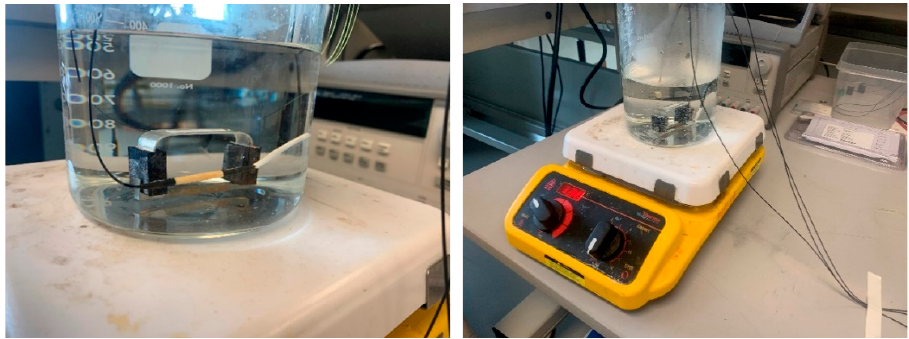
Figure 21. Corrosion sensor, given a temperature change, Δ T.